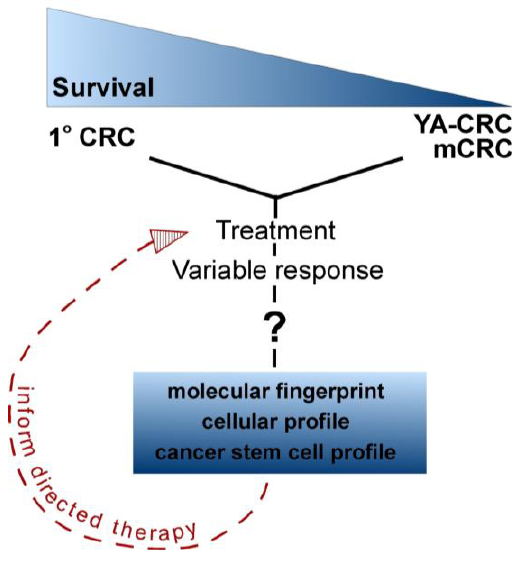
Figure 2. Colorectal cancer (CRC) has better survival odds than metastatic CRC (mCRC) or young-adult CRC (YA-CRC). The difference in disease response to the current state-of-the-art treatment reflects a gradient of disease with the early staged primary CRC (1 o CRC) responding more favorably than late stage CRC, YA-CRC or mCRC. The variability in treatment response is likely dependent upon differences in molecular and cellular characteristics among the disease spectrum. The current challenge is to understand these differences to inform targeted therapy with the ultimate goal of cancer